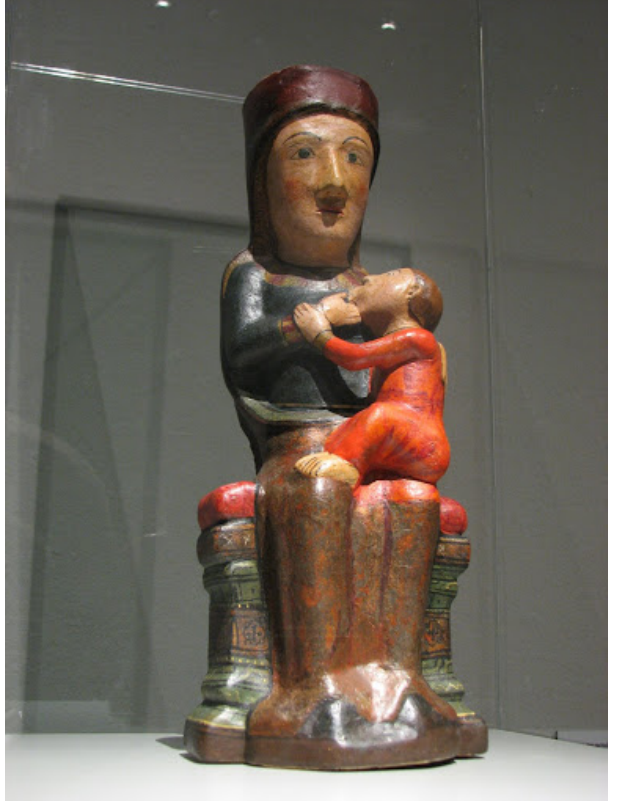
y lo fill de giner veren vna claror que se espantaren